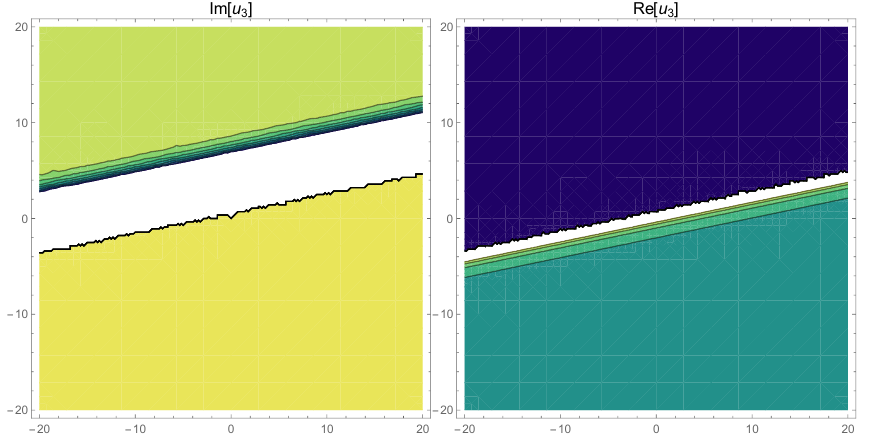
Figure 7. The 3D figures of Equation (15).